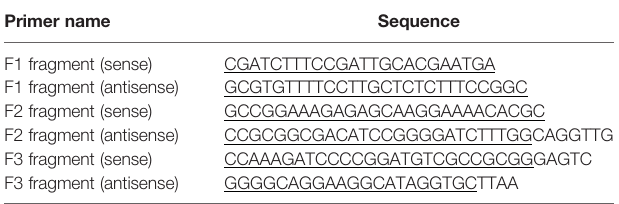
TABLE 5 | Sequences of primers for recombined virus